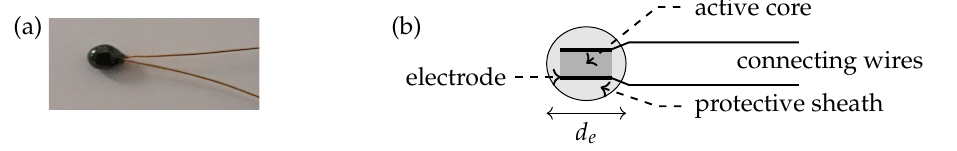
Figure 1. ( a ) Precision miniature epoxy encapsulated bead-type 44004 NTC thermistor (2252@25) from Omega and ( b ) its schematic composition. The length of the connecting copper wires is equal to L = 76 mm in the present